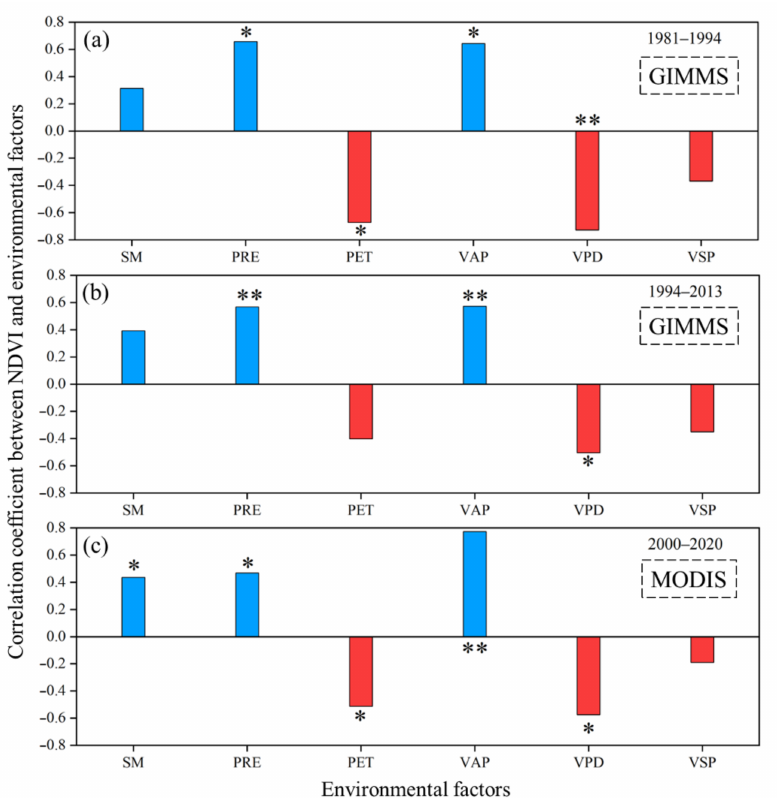
Figure 7. Average annual correlation between environmental factors (SM, PRE, PET, VAP, VPD, and VSP) and NDVI: ( a , b ) average annual correlations about GIMMS NDVI before and after 1994, respectively; ( c ) average annual correlations about MODIS NDVI from 2000 to 2020. Note that * indicates significance ( p < 0.05) and ** indicates extreme significance ( p < 0.01).